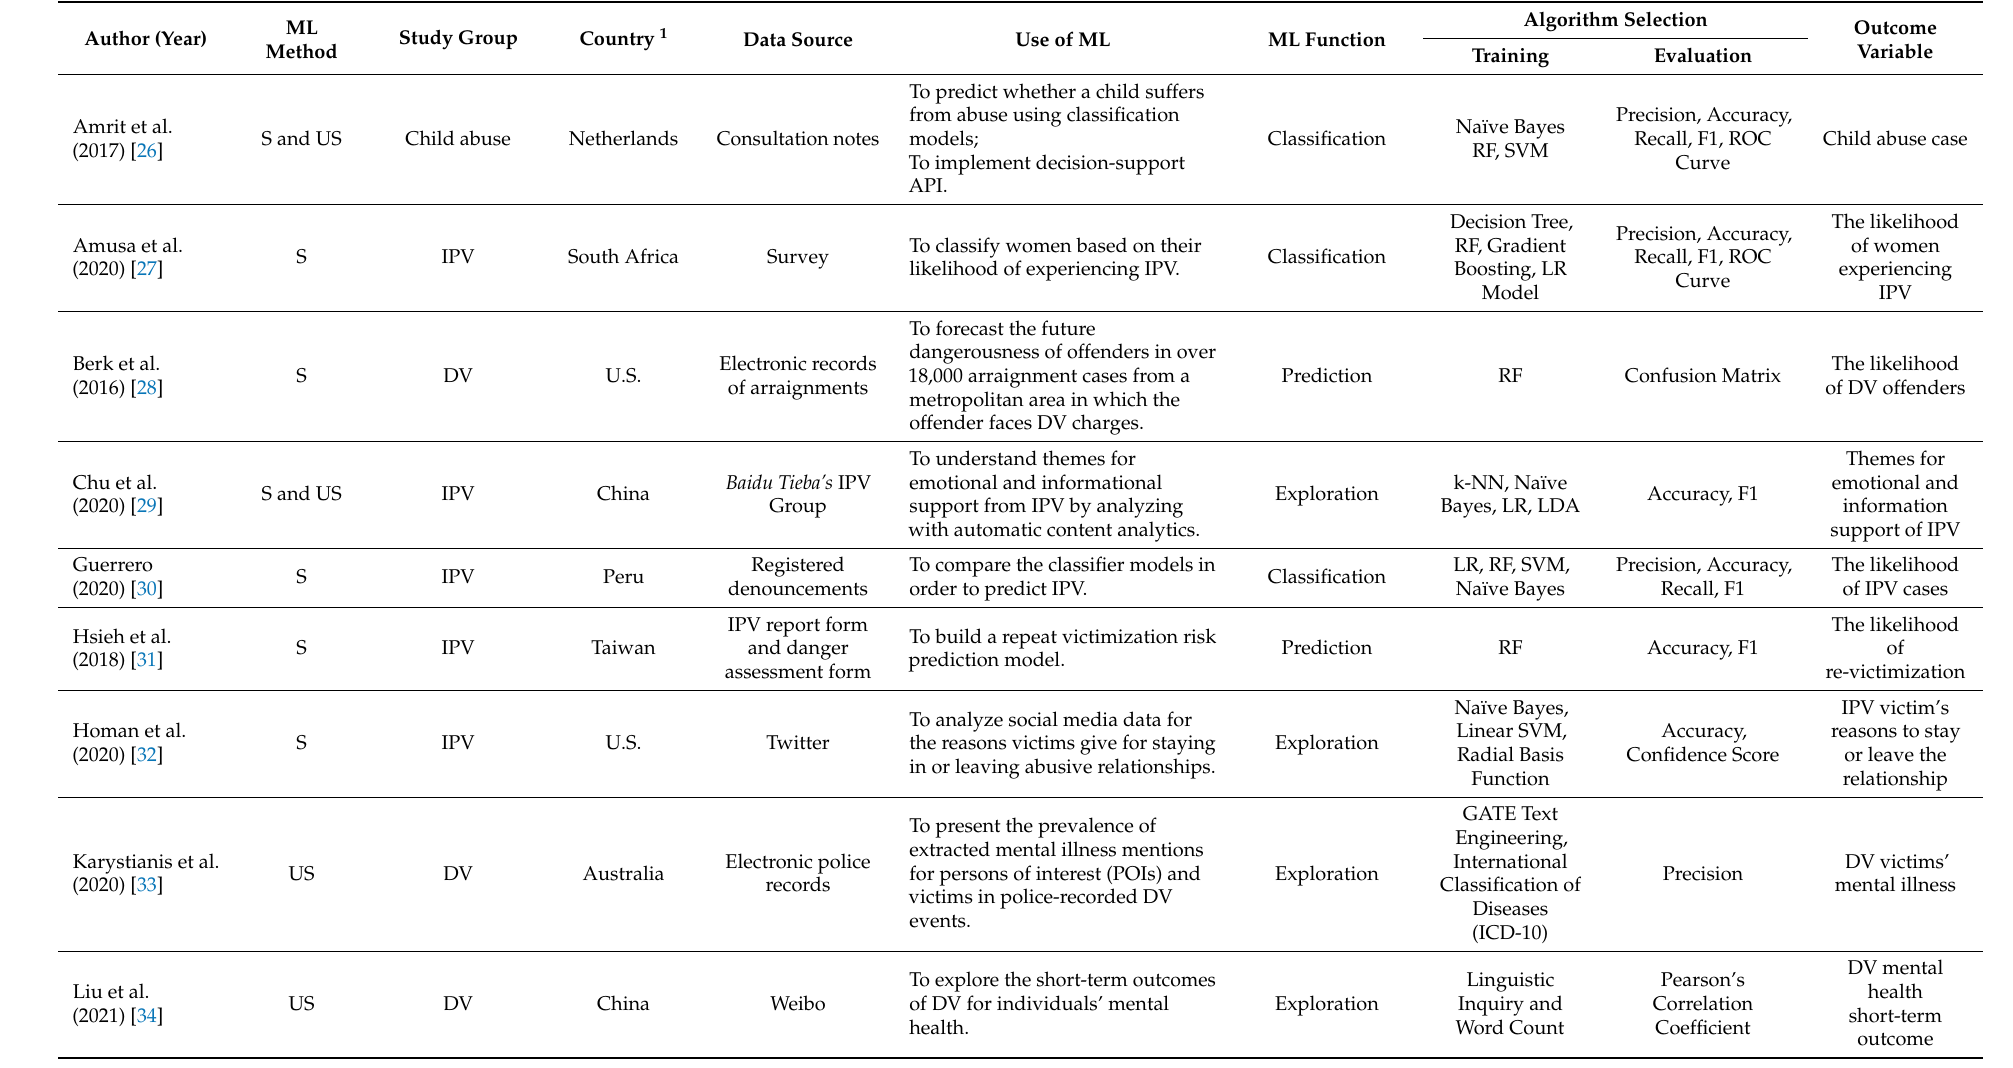
Table 2. An integrative review of the included studies (results shown in alphabetical